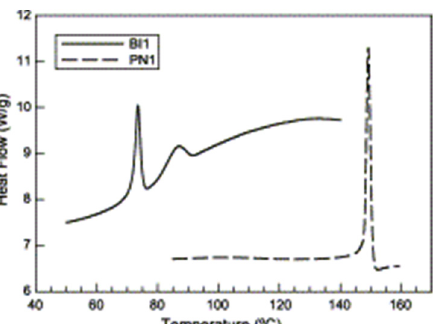
Figure 28. DSC thermogram. Solid line: Composite BI1; the 75 °C peak conforms to the melting point of the microcrystalline ibuprofen stage, whereas the β -CD dehydration is correlated with the highest point at 85 °C. Broken/dotted line: Composite PN1; the maximum point is correlated with the melt- ing of the microcrystalline nimesulide stage. Reproduced with permission from [330].